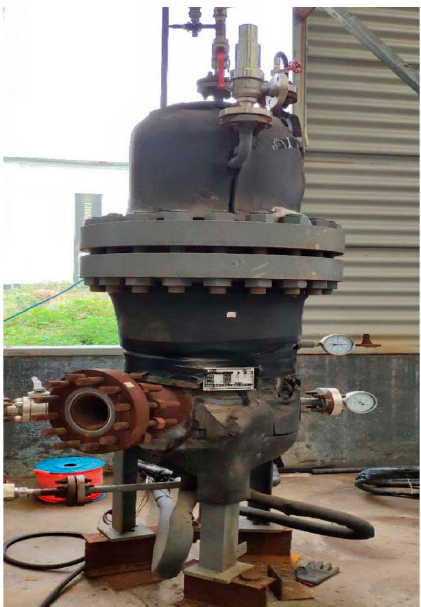
Figure 1. Reactor equipment.